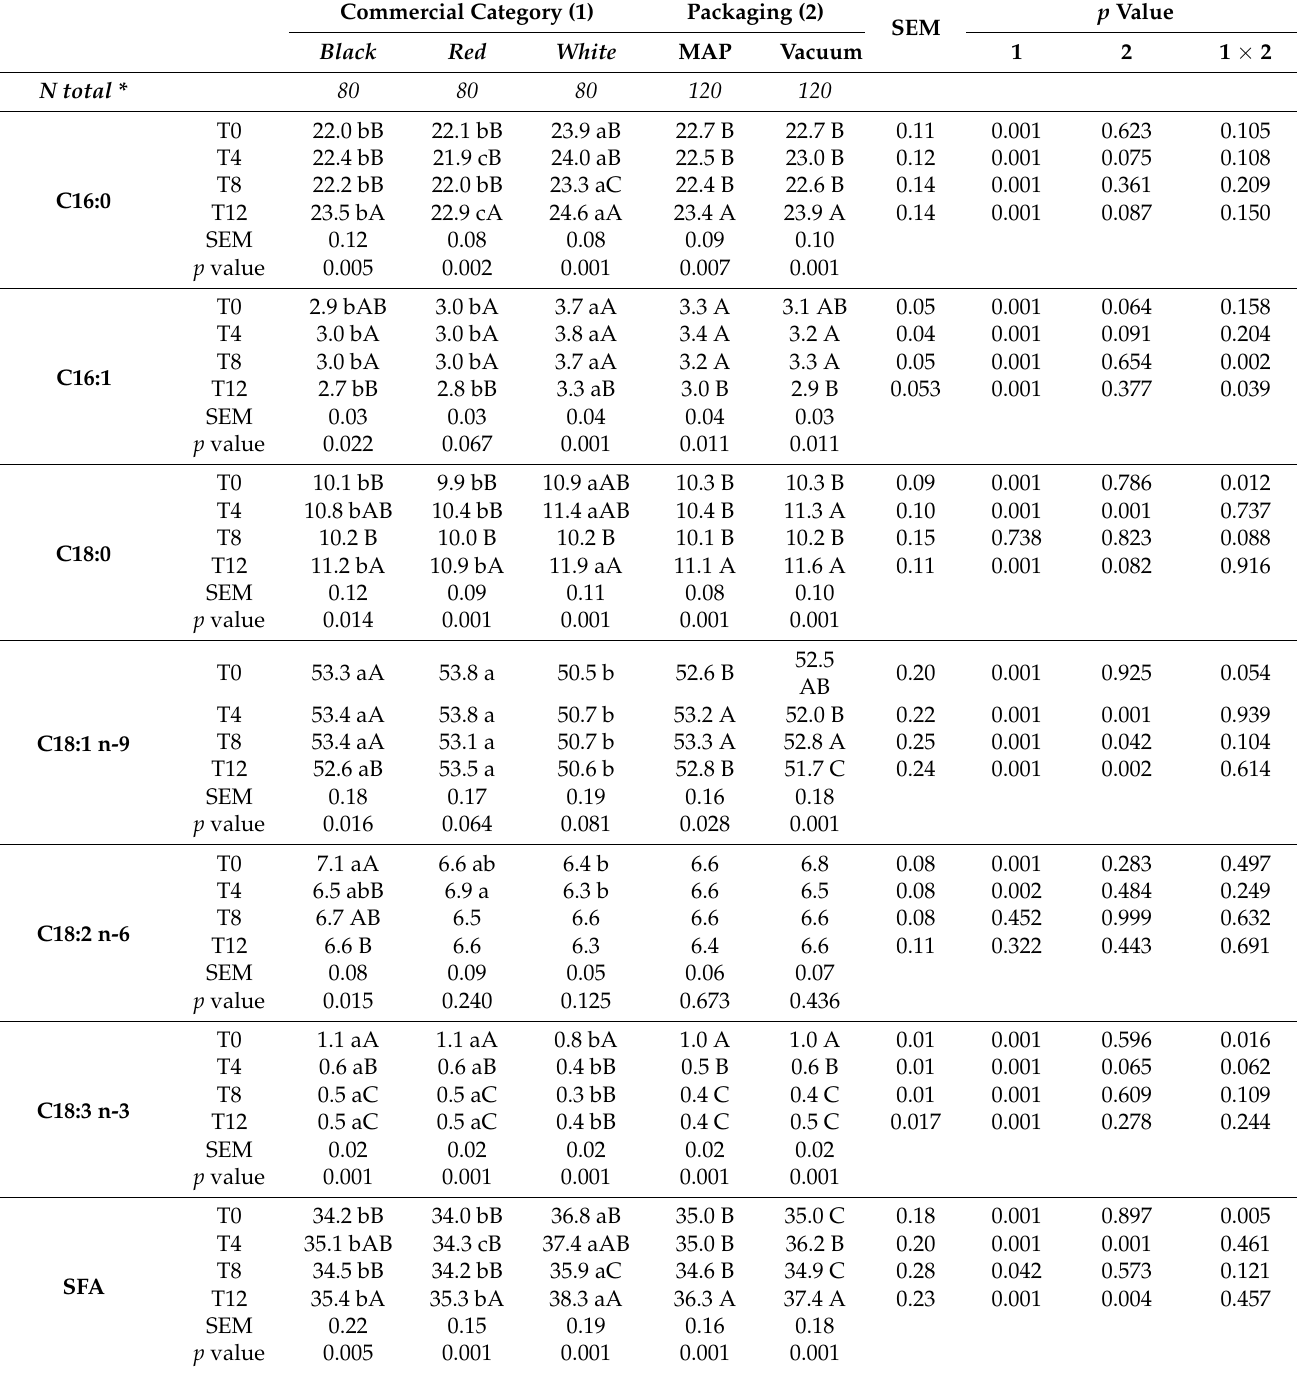
C18:1 n-9 (T4, T8 and T12). Interactions at T0 are difficult to explain; however, interactions during storage could be caused by differences in the lipolytic effect of enzymes in slices from each category due to the type of packaging, which could cause changes in the fatty acids’ percentage during storage. Table 4. Fatty acids profile (per cent of FAMEs) changes of sliced Iberian dry-cured ham from different commercial categories and with different packaging conditions for 12 months of refrigeration